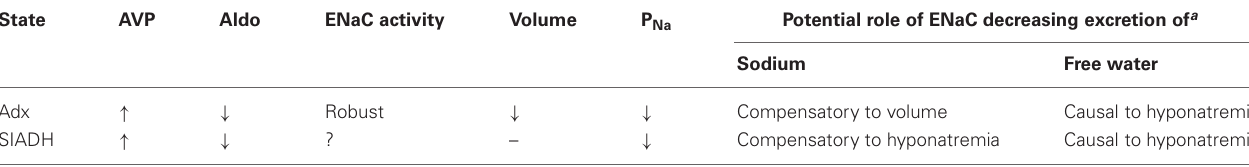
Table 1 | The consequences of active ENaC in states of high AVP and low